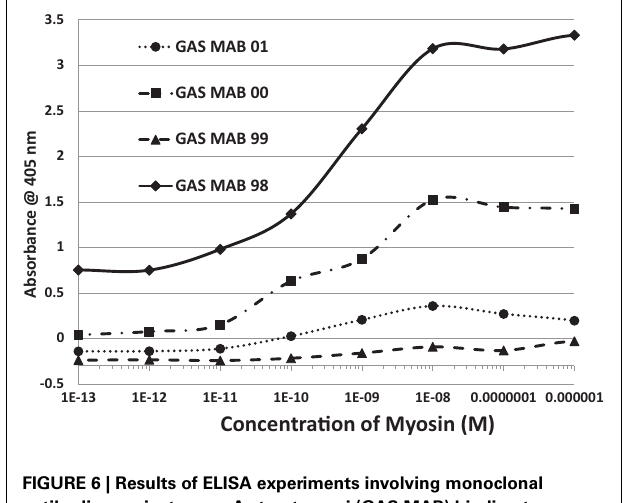
FIGURE 7 | Results of ELISA experiments involving monoclonal antibodies against groupA streptococci (GAS MAB) binding to laminin 1 . Binding constants for Table 3 were derived from the inflection points of the curves.